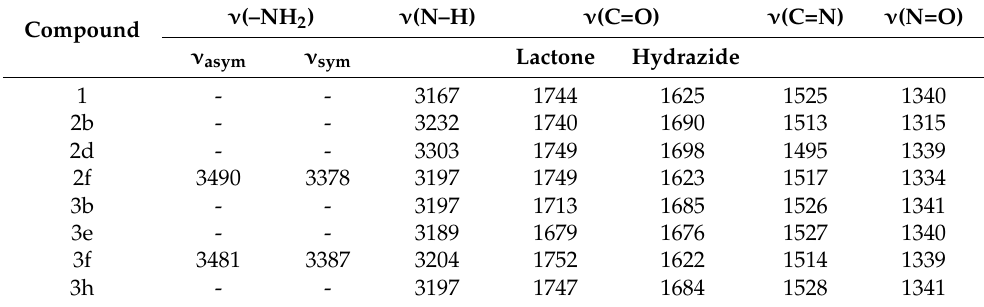
Table 7. Characteristic band-strength values of the synthesized 5-nitroisatin-based benzoylhydrazines.